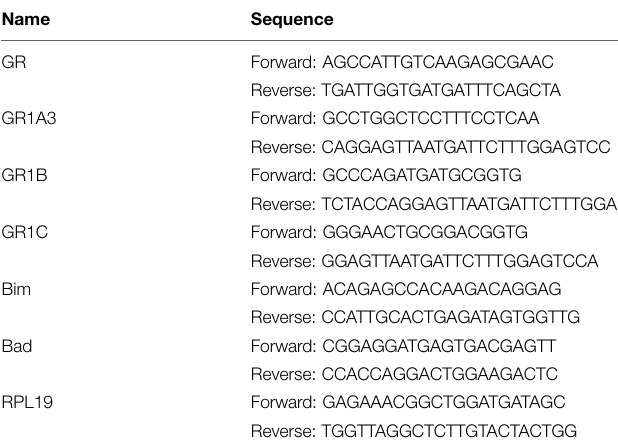
TABLE 1 | Sequences of primers used for quantitative real-time